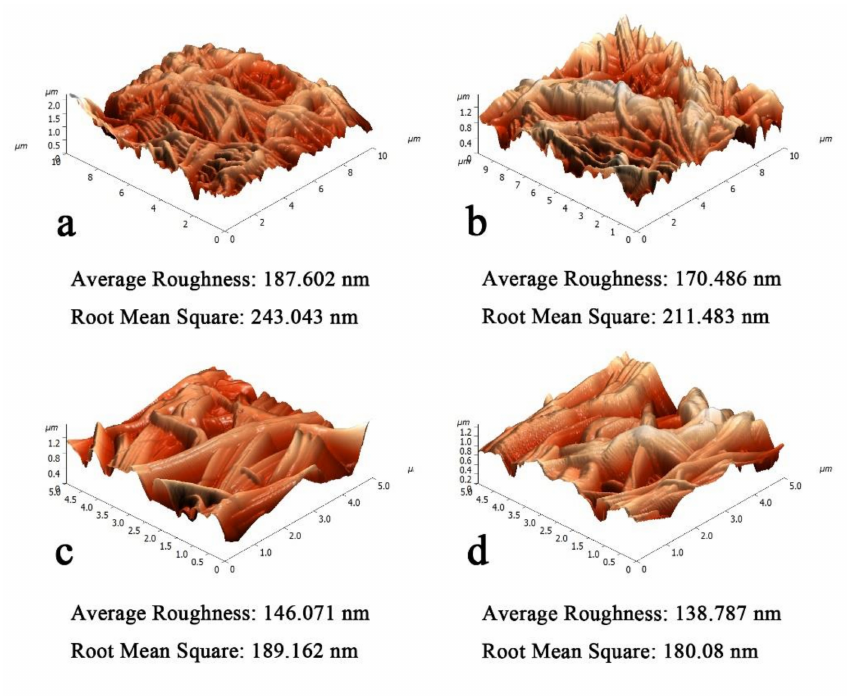
Figure 6. Apparent structure diagram (AFM) of different areal densities of HNM: ( a ) 4.3 g/m 2 ,